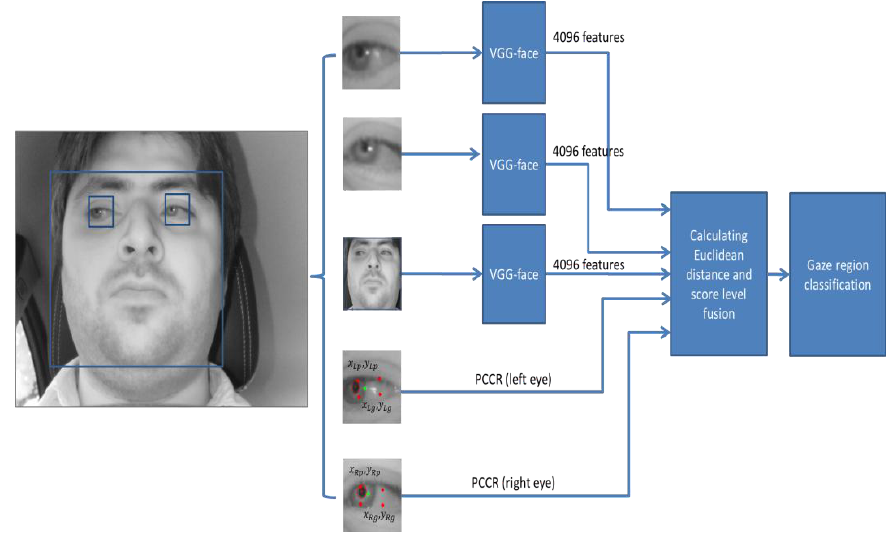
Figure 8. CNN-based driver’s gaze classification procedure with PCCR vector (scheme 2).